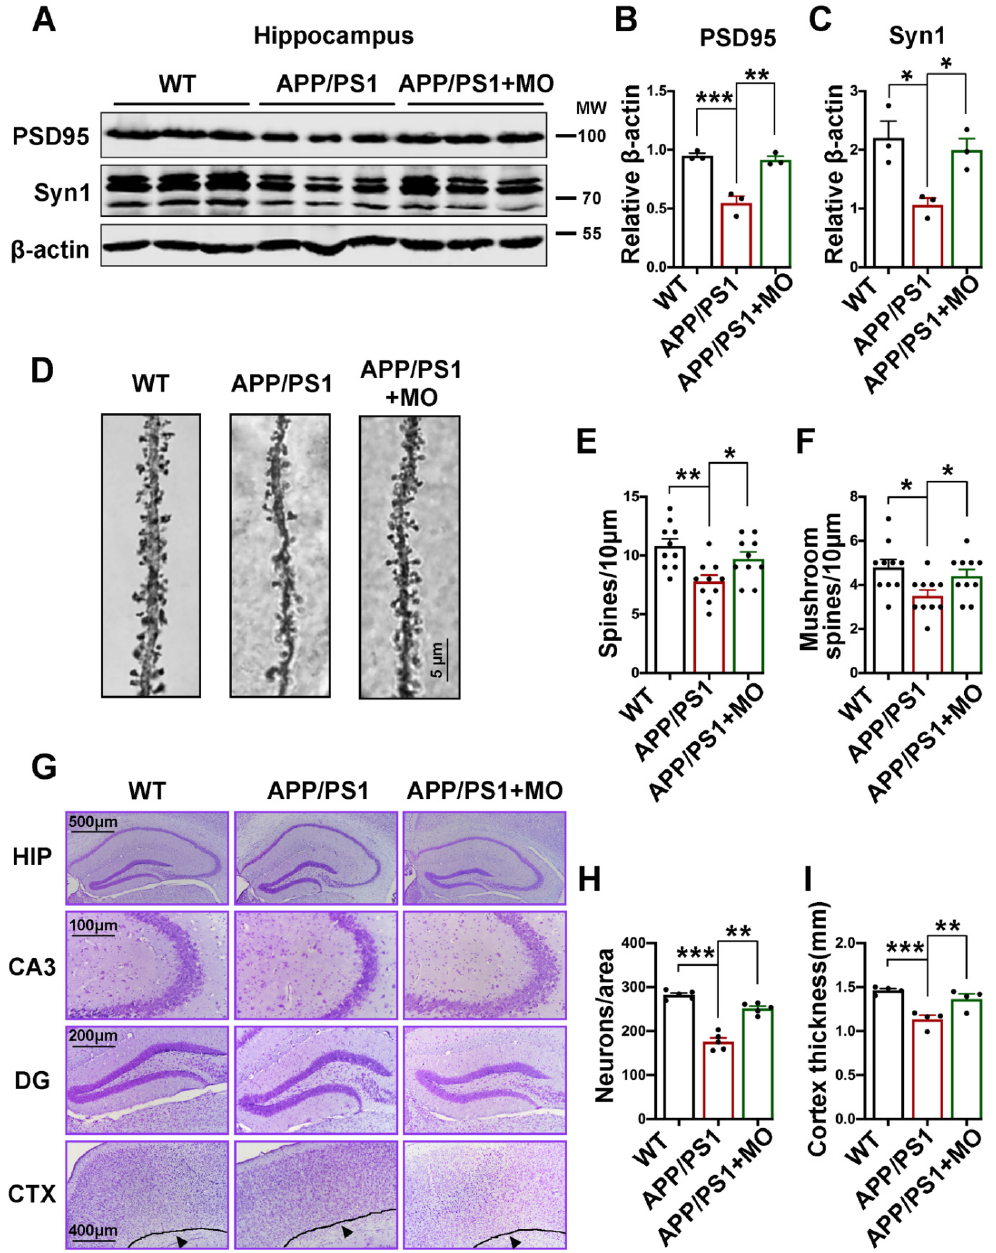
Figure 6. Long-term MO treatment prevents synaptic proteins and dendritic spines losses and neurodegeneration in APP/PS1 mice. ( A ) The expression level of PSD95 and Synapsin1 from hippocampal lysates of WT control and APP/PS1 mice with or without MO treatment was examined by Western blotting, ( n = 3). ( B , C ) The statistical analysis of Western blot bands from panel A. β -actin serves as the loading control. ( D – F ) Golgi staining results. ( D ) The representative micrographs of the Golgi staining experiment (scale bare = 5 µ m, n = 3 per group, 3–4 dendrites per mouse). ( E ) Total spines number per 10 µ m area. ( F ) The mushroom-type spines per 10 µ m area. ( G – I ) Nissl staining results (scale bars = 100, 200, 400, and 500 µ m, n = 3). ( G ) The representative micrographs of the Nissl staining experiment. ( H ) The number of neurons per area. ( I ) The thickness (mm) of the cortex. The data are presented as Mean ± SEM. * p < 0.05; ** p < 0.01; and *** p < 0.001 vs. WT or vs. APP/PS1 mice